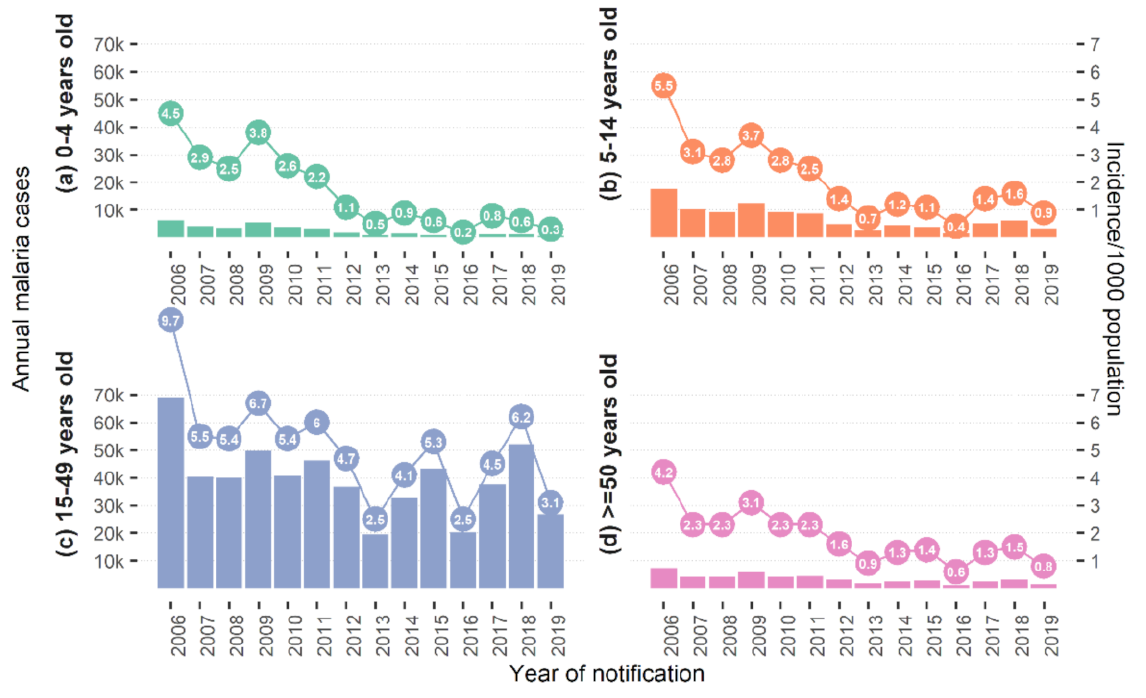
Figure 3. Here: Malaria incidence (confirmed + unconfirmed cases) per 1000 by age groups ( a ) 0–4, ( b ) 5–14, ( c ) 15–49, ( d ) ≥ 50, in 2006–2019,